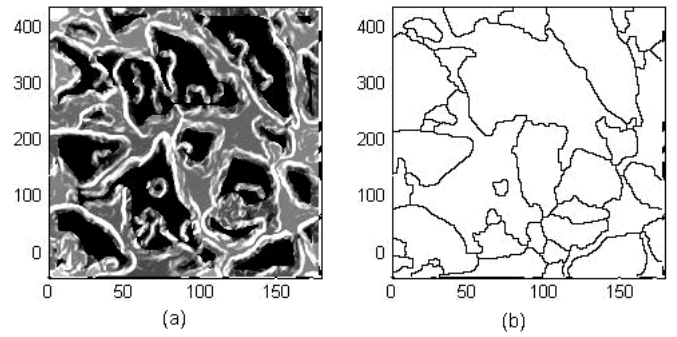
Figure 9. ( a ) Gradient image; ( b ) watershed transform.